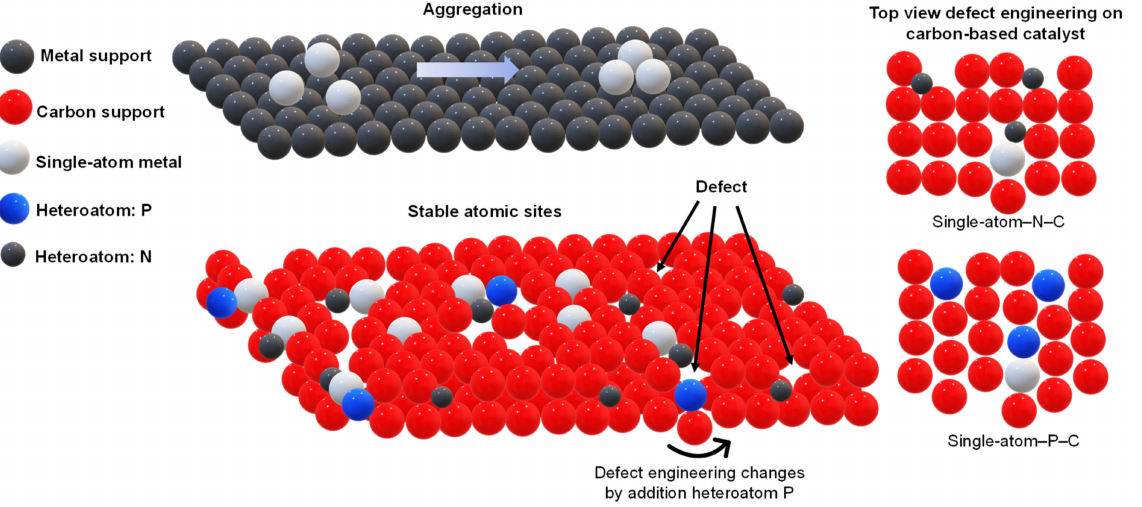
Figure 3. Illustration of heteroatoms-doped metal and carbon